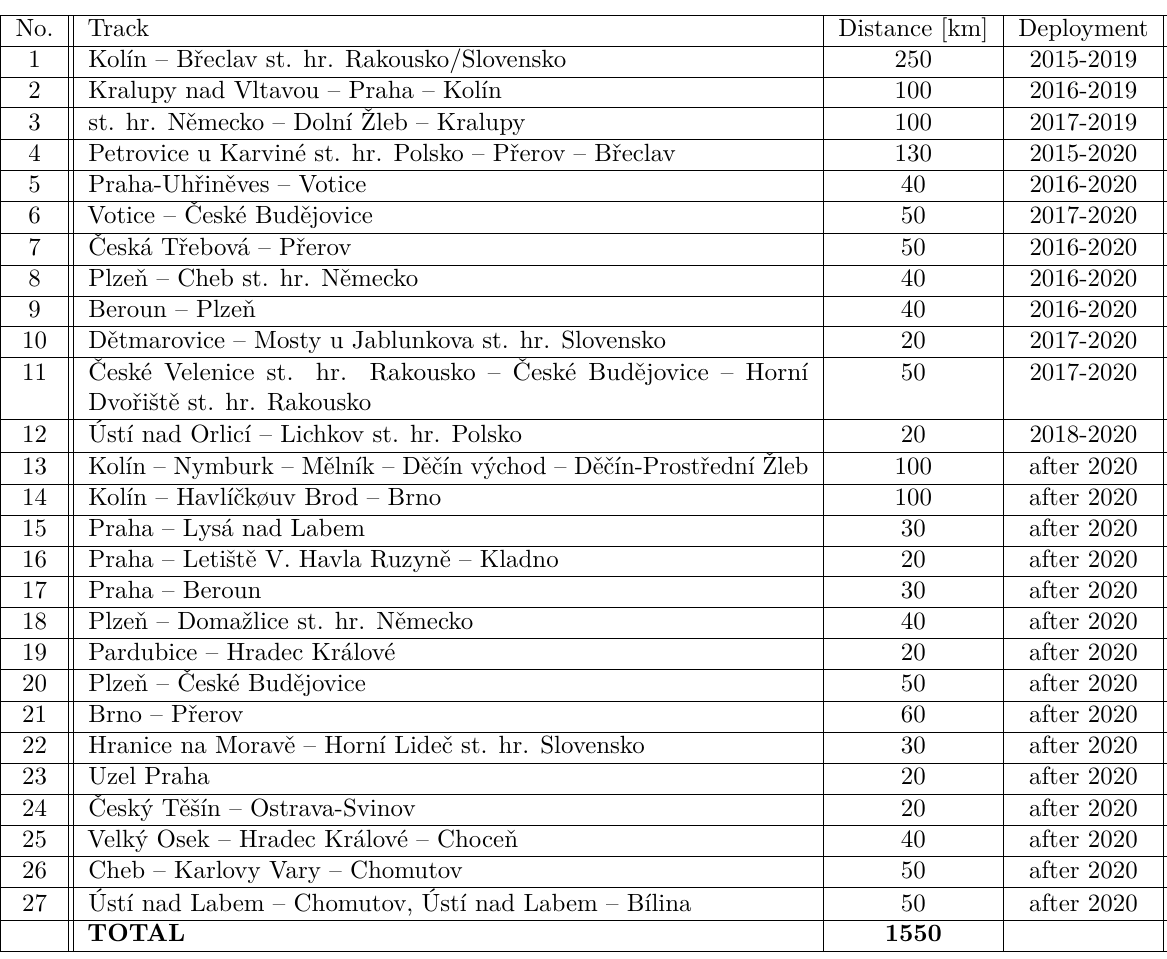
Table 3. Expected track deployment of ETCS L2